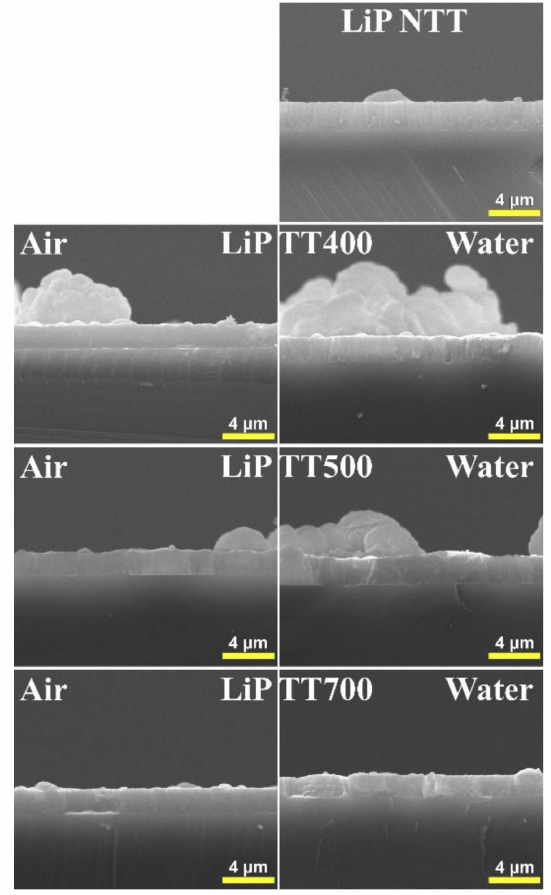
Figure 7. Cross-view SEM micrographs of control Ti, NTT LiP samples and of those subjected to post-deposition thermal treatments (at different temperatures), in air and water-vapor ambient, synthesized onto Si